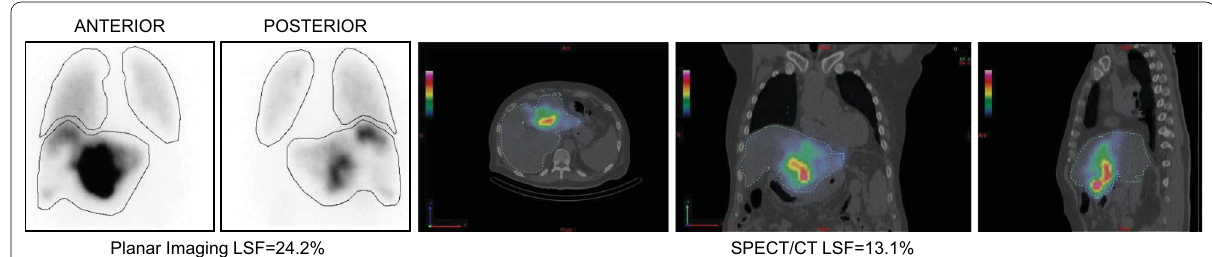
Planar Imaging Fig. 3 Significantly higher LSF of 24.2% from 99m Tc-MAA planar imaging versus LSF of 13.1% from 99m Tc-MAA SPECT/CT (patient 43; Table